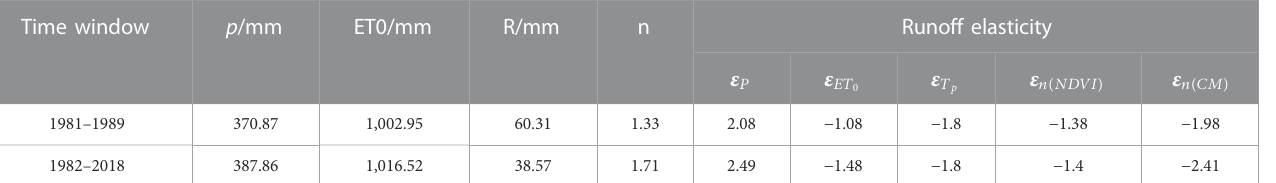
TABLE 2 Change of elastic coef fi cient of each factor in two periods. Time window